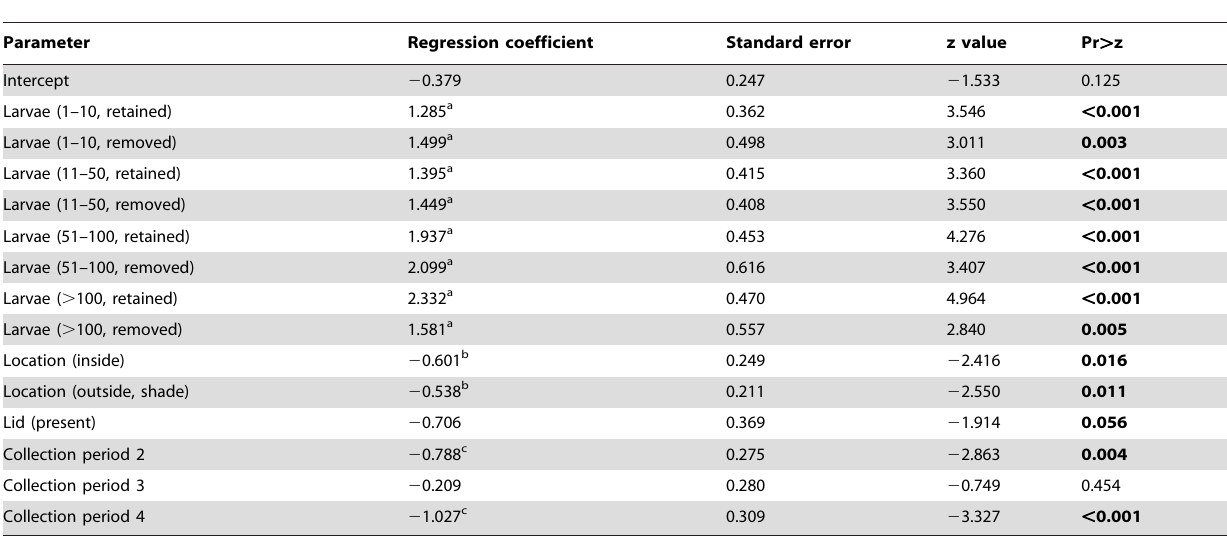
Table 2. Parameter coefficients for logistic regression model predicting probability of oviposition (n=591 containers).